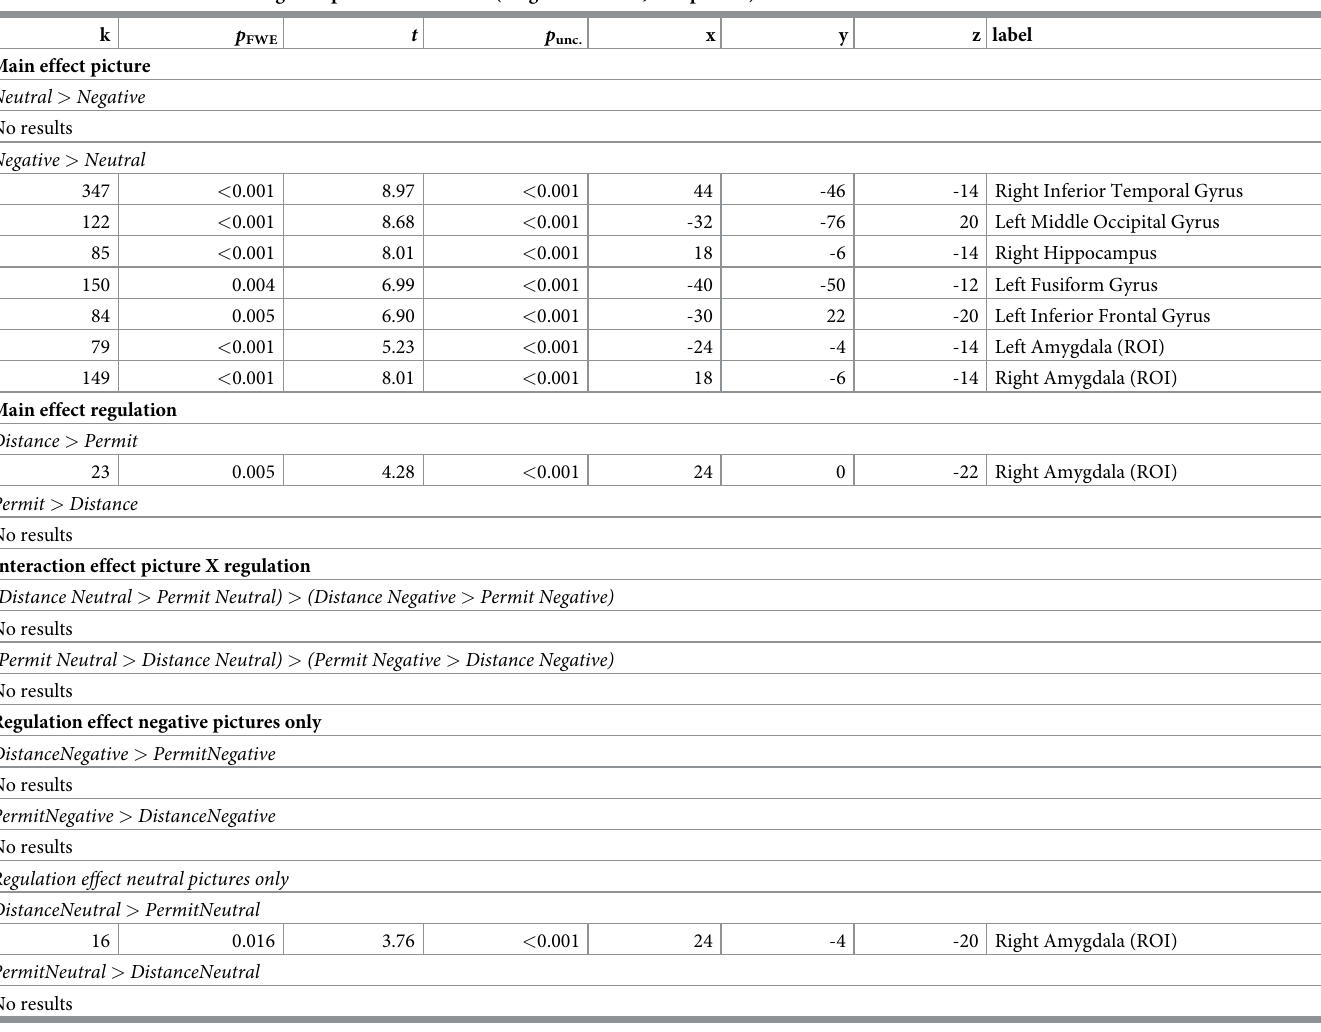
Table 5. Activation maxima during re-exposure after 1 week (long-term effects, timepoint